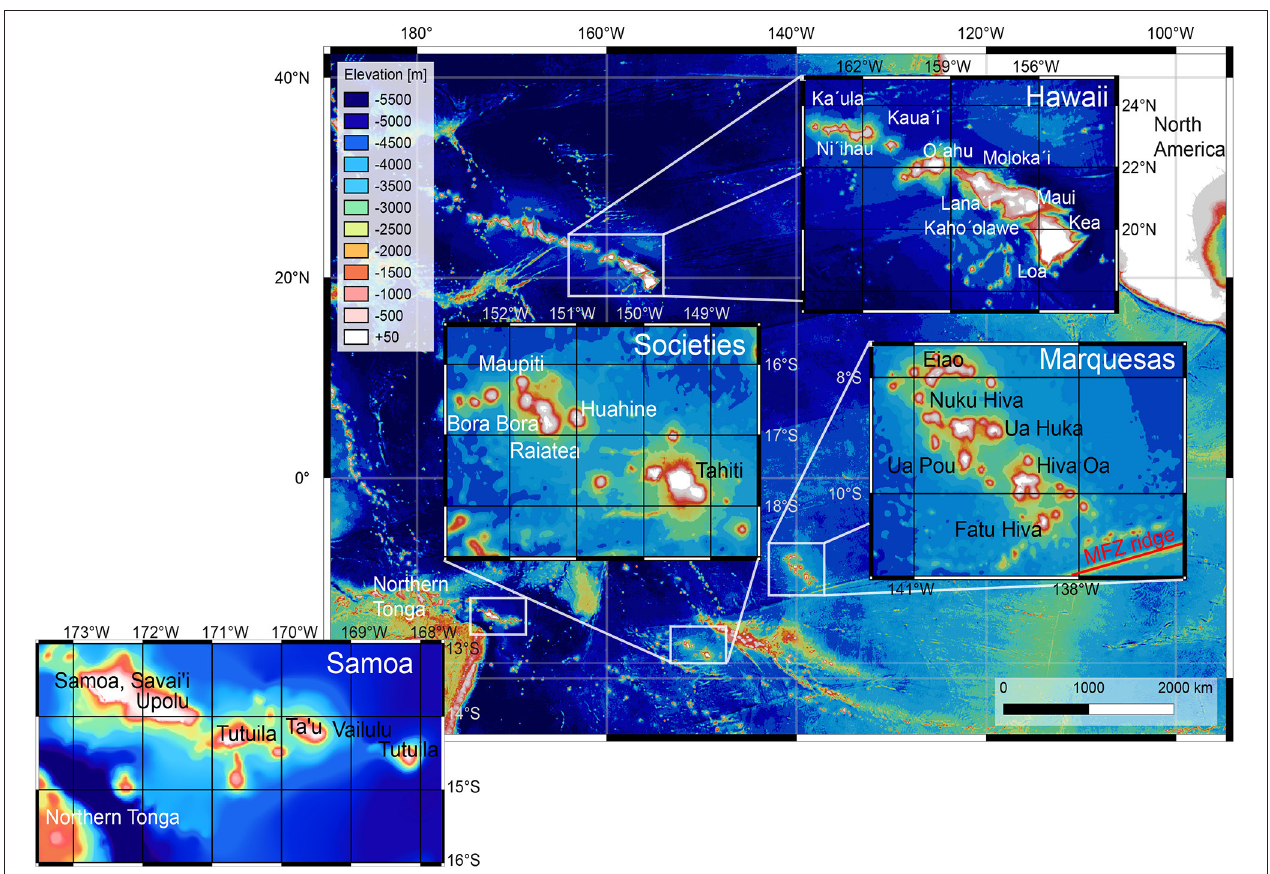
FIGURE 1 | Overview map of the Central and Northern Pacific including the Hawaiian, Marquesas, Samoa, and Society island